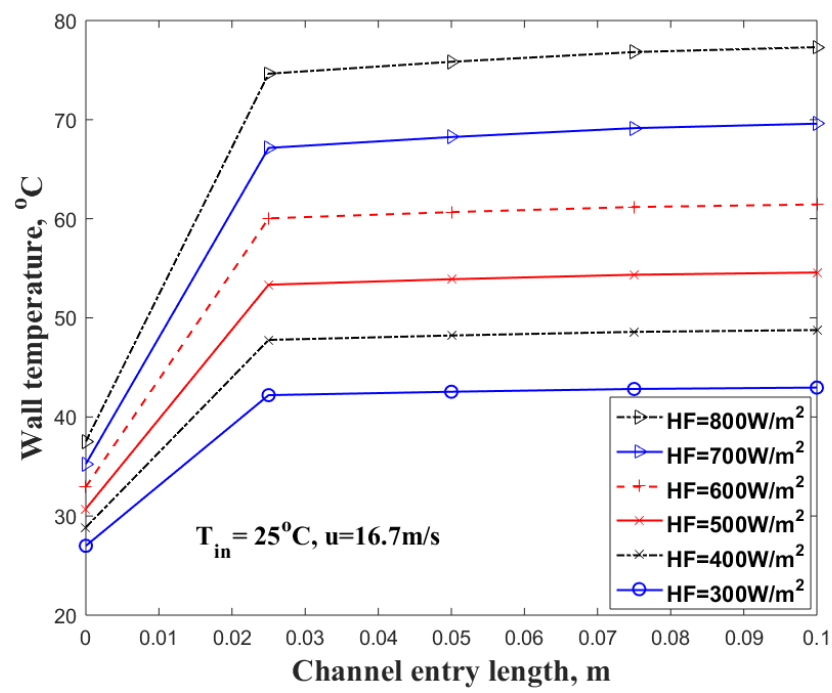
Figure 7. Effect of distance from the inlet on linear wall temperature profile at T = 25 °C and u = 16.7 m/s.